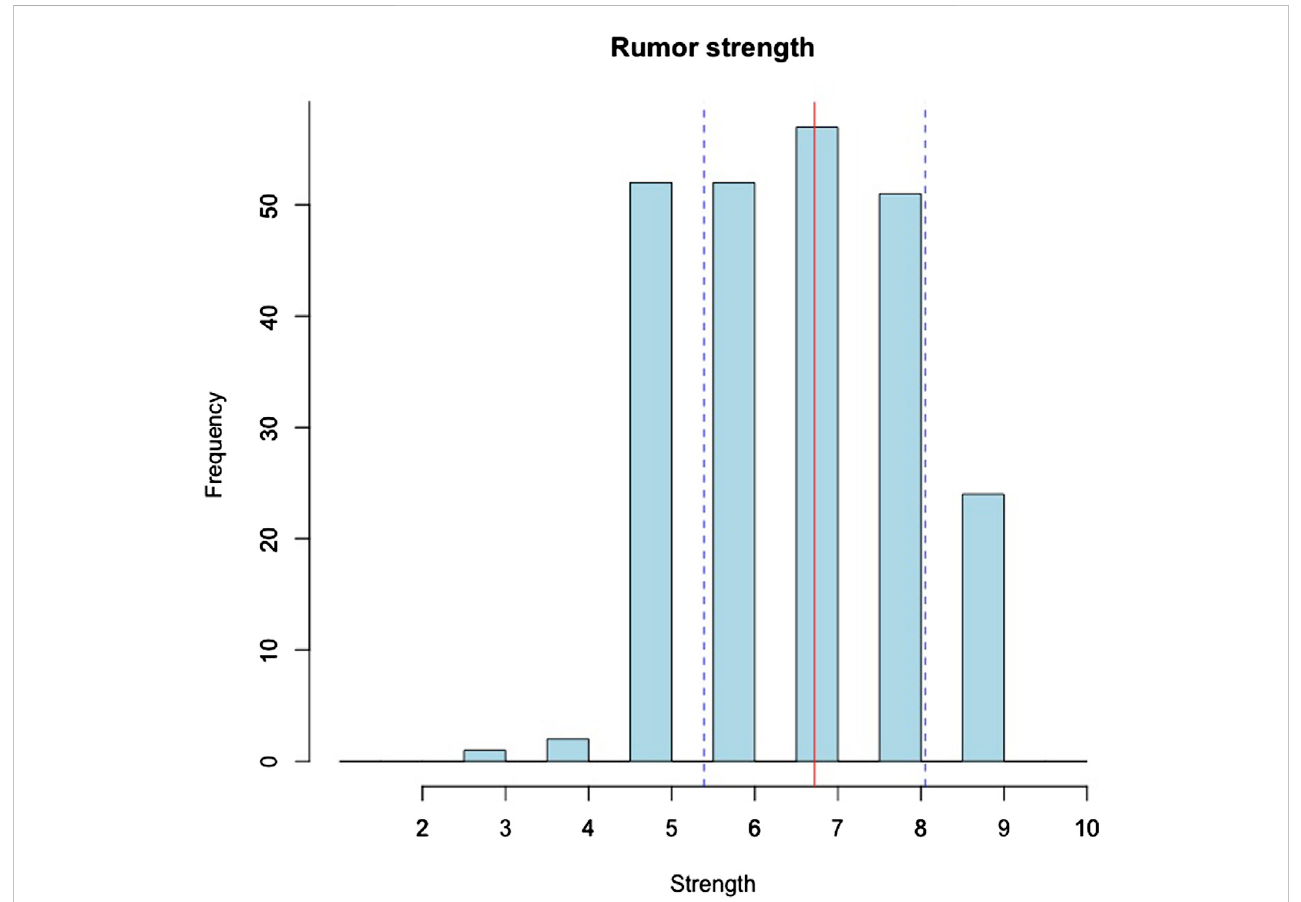
Rumorstrengthdistribution.Verticallinesindicatethemeanvalue(red)andstandarddeviation(blue,dashed).Thestrongestrumors(R=9)aremorethan one standard deviation above the mean. They are listed in Table